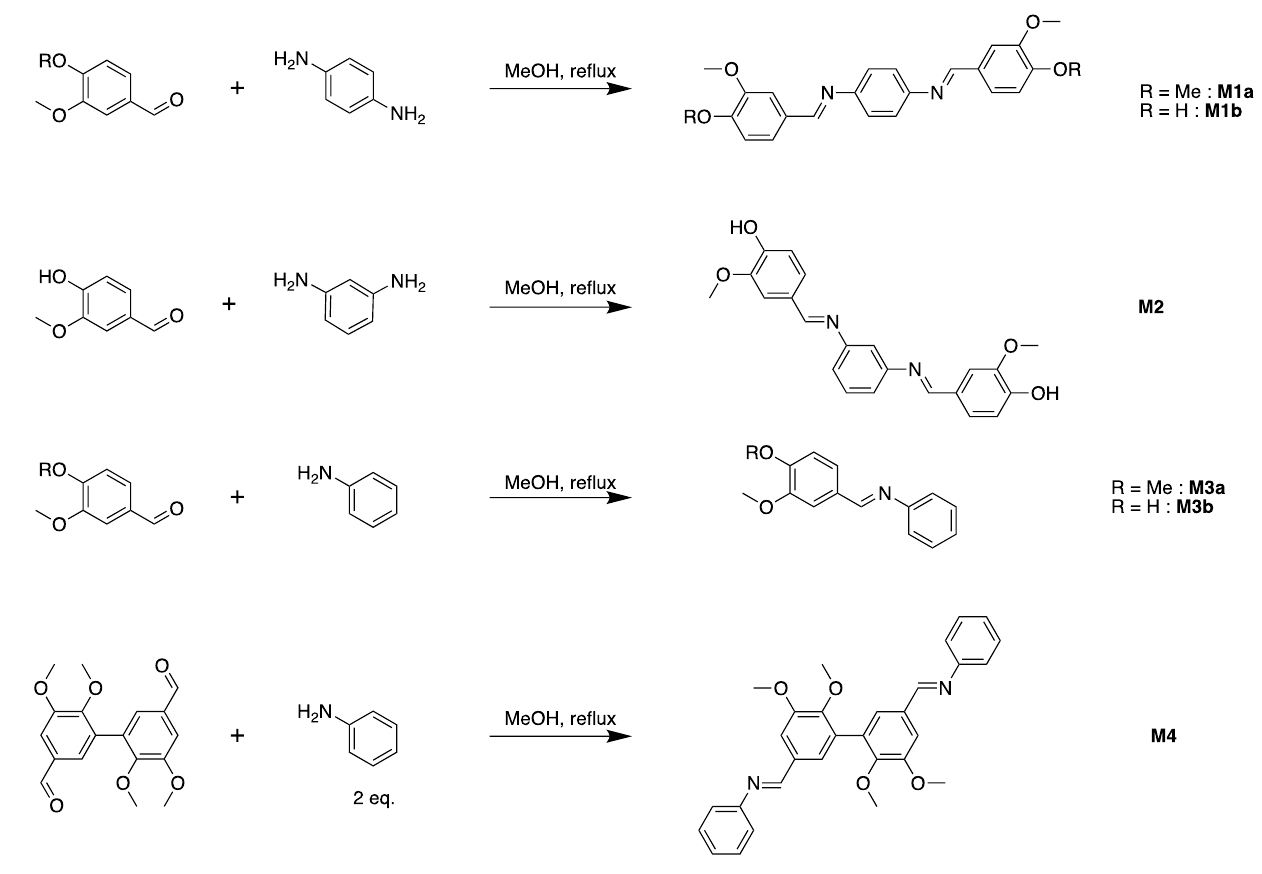
10 of 16 Figure 3. Absorbance spectrum and emission-excitation spectra of P1 in film (drop-casted on quartz).